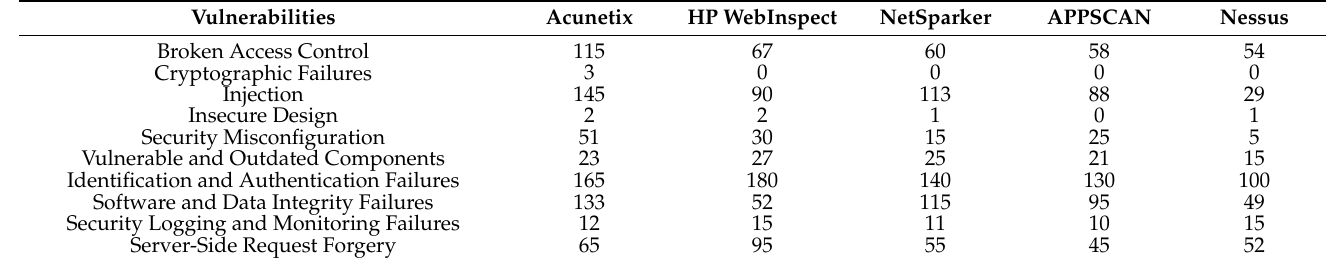
Table 3. Total number of vulnerabilities classified and detected by proprietary scanners.